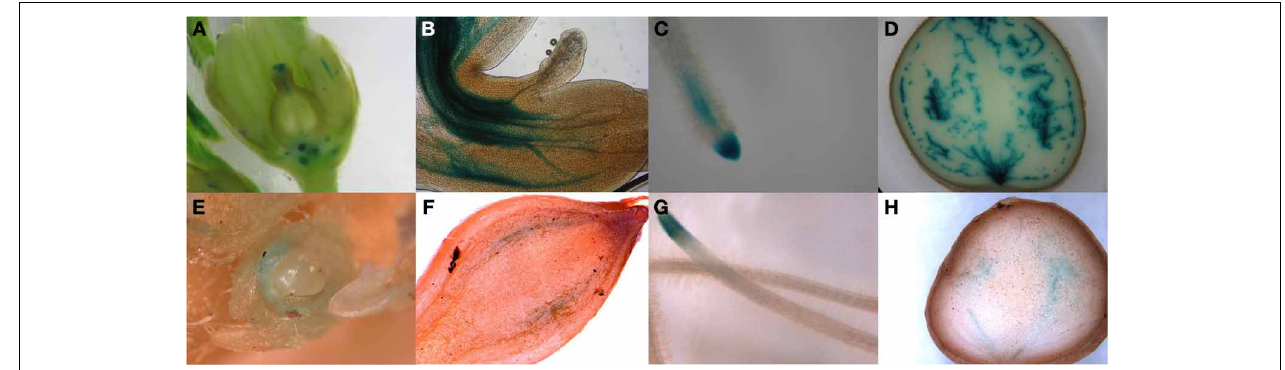
FIGURE 4 | Pin promoter expression study. Gus expression driven by the StPIN4 promoter is detected in flowers (A) , stolon tip (B) , root tip (C) swelling tuber (D) and StPIN2 expression was found the in flower bud (E) , swelling stolon (F) , root tip (G) and in swelling tuber (H)